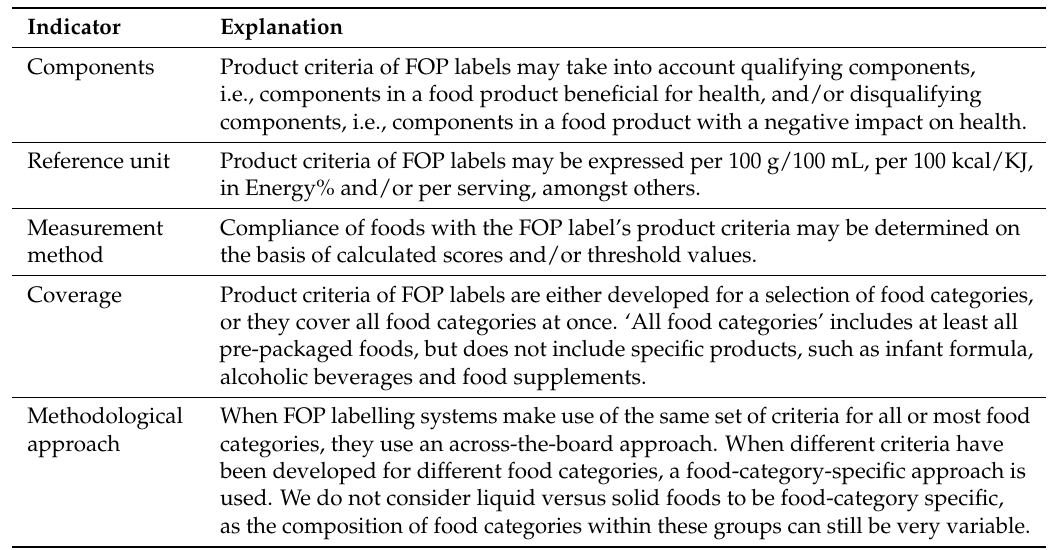
Table 1. A summary of indicators that are used in the Funnel Model to describe aspects of front-of-pack (FOP)